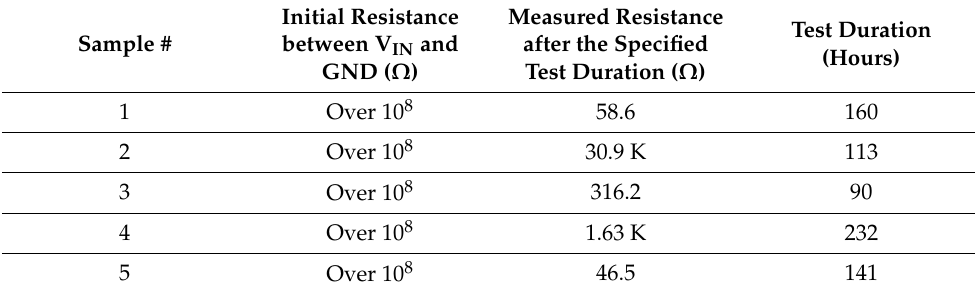
Table 1. Change in resistances after temperature/humidity test.